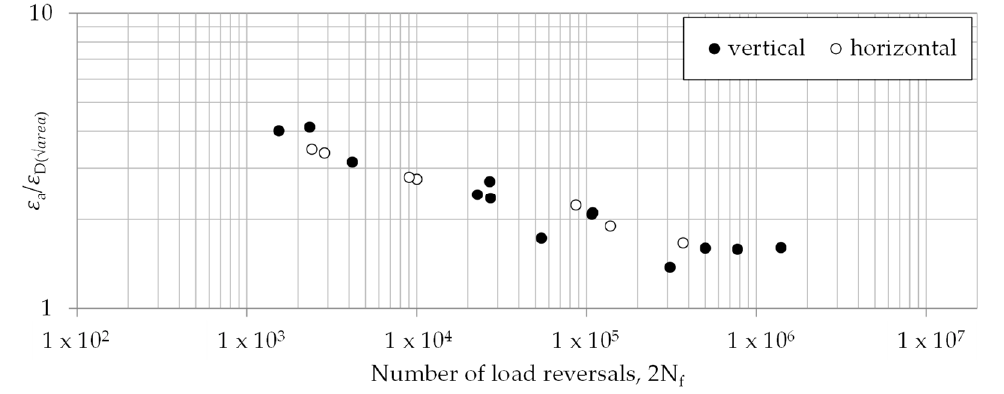
Figure 13. Modified strain-life data following an adapted Murakami’s approach.